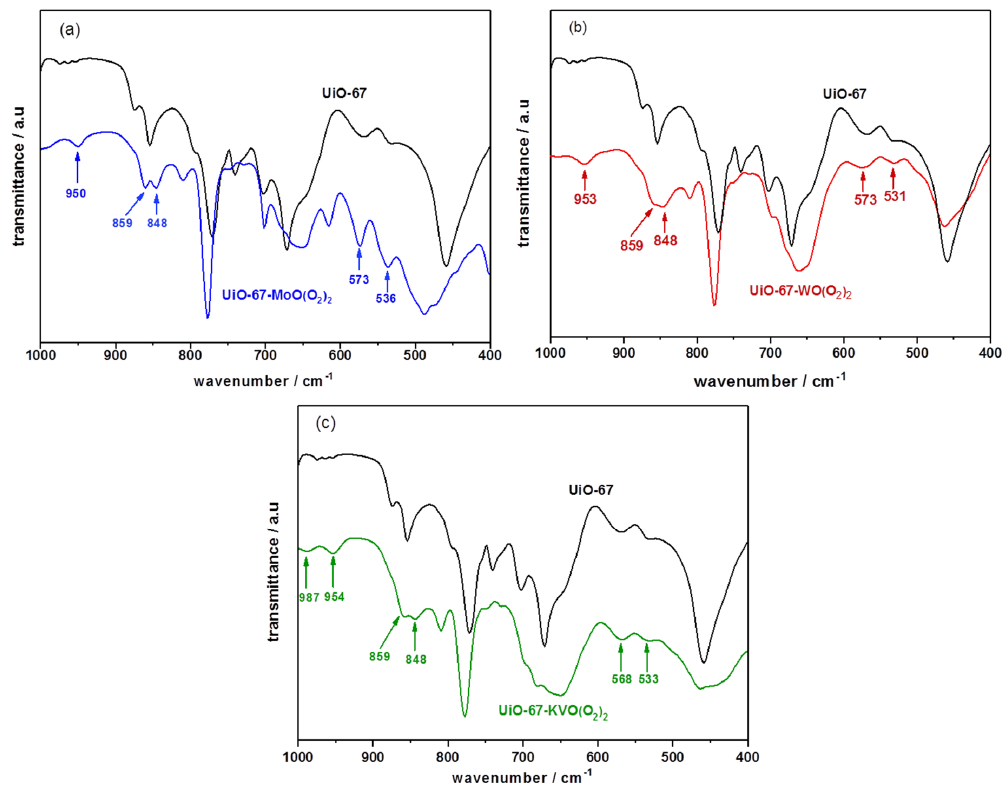
Figure 2. FTIR spectra of UiO-67, UiO-67-MoO(O 2 ) 2 , UiO-67-WO(O 2 ) 2 and UiO-67-KVO(O 2 ) 2 . Table 1. The specific surface area and mass fraction of active metal of modified metal-organic frameworks